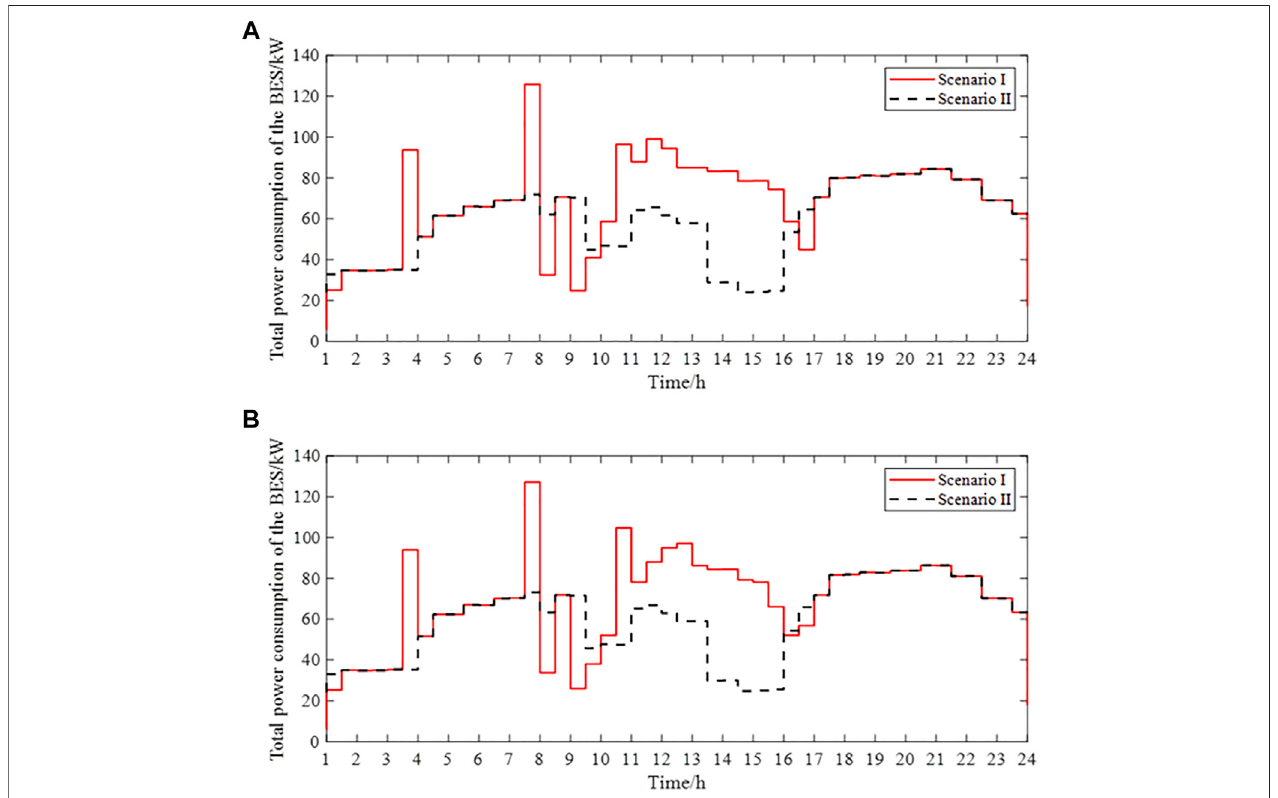
FIGURE13| Correspondingtotalpowerconsumptionfromthegridwhentheoptimalschedulingresultsare f opt- and f opt+ . (A) TotalpowerconsumptionoftheBES when the optimal scheduling result is f opt- . (B) Total power consumption of the BES when the optimal scheduling result is f opt+ .